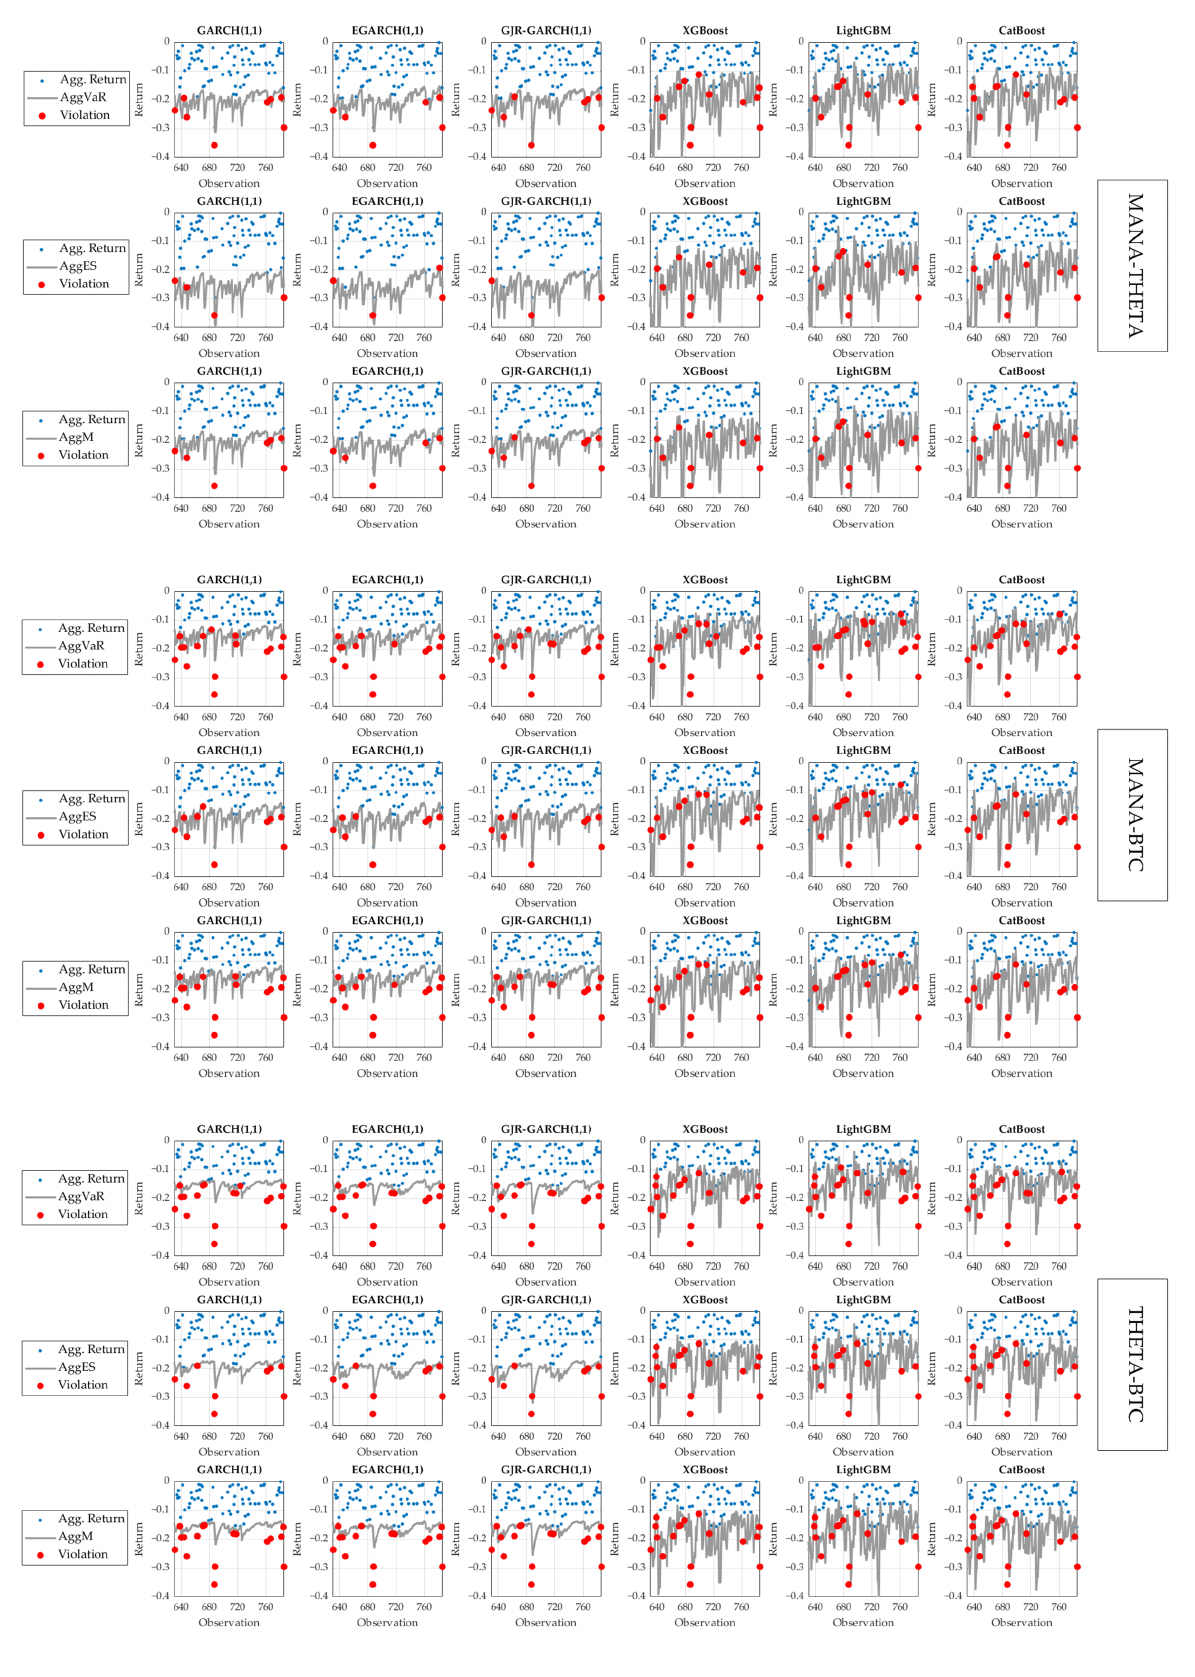
Figure 6. Aggregate risk measure